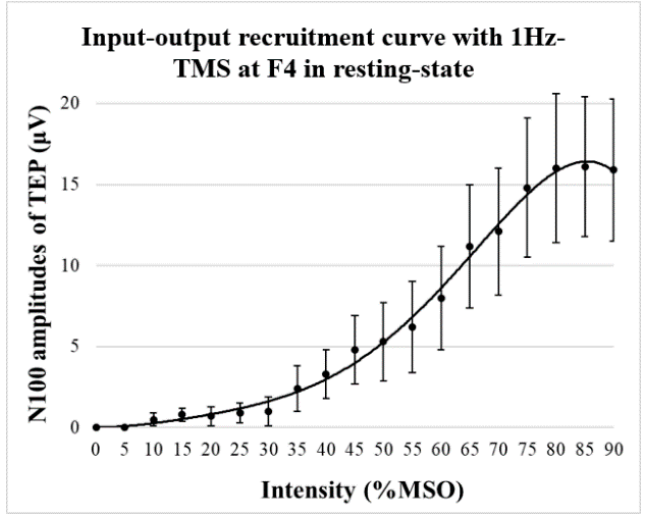
Figure 1. Recruitment curve of N100 component of TMS-evoked potentials (TEPs) at the stimulation site. The graph shows the recruitment curve at the F4 electrode site where 1Hz-TMS was administered. It shows that the input-output (I-O) curve increases nonlinearly with intensity and plateaus at an intensity of 80% maximum stimulus output (MSO).